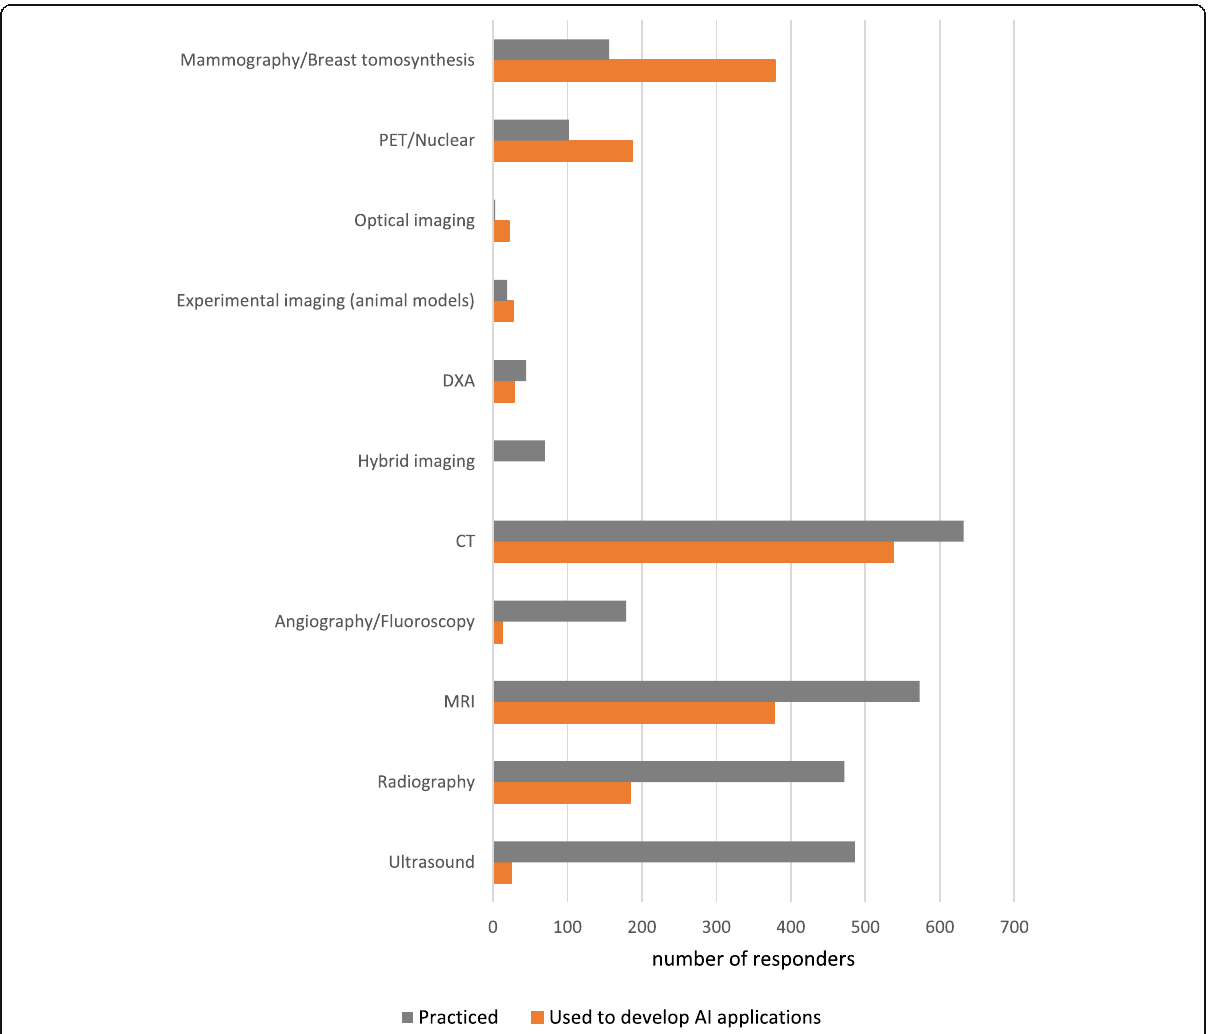
Fig. 4 Distribution of responders. Grey bars represent the number of responders that practiced each imaging modality, while the orange bars represent those who believe that that modality will be used to develop AI applications. Imaging modalities are sorted according to the difference between values of orange and grey bars. PET: positron emission tomography; DXA: dual X-ray absorptiometry; CT: computed tomography; MRI: magnetic resonance